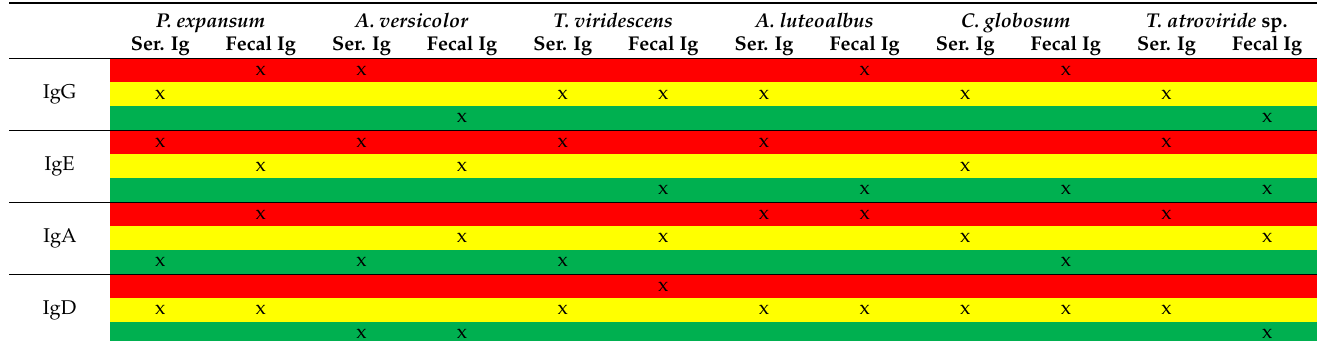
Table 5. Comparison of the results; exposed vs. controls in data extracted from Figure 2 vs. Figures 3 and 4 vs. Figure 5. The red color indicates an increase in the Ig response of exposed subjects when compared to the controls. The yellow means that there is no difference between the study groups, whereas green refers to a decrease in the level of that Ig when the exposed subjects are compared to controls. In general, it appears that if there is an increase in the Ig response in serum, the Ig in question does not display an increase in the fecal Ig response or vice versa. An exception (x) is found in the IgA level of A. luteoalbus , in which only the highest serum and lowest fecal IgA levels of the studied sample dilutions show increased results in exposed vs. controls. Moreover, in A. versicolor , the IgD results are decreased in the exposed both in serum and fecal